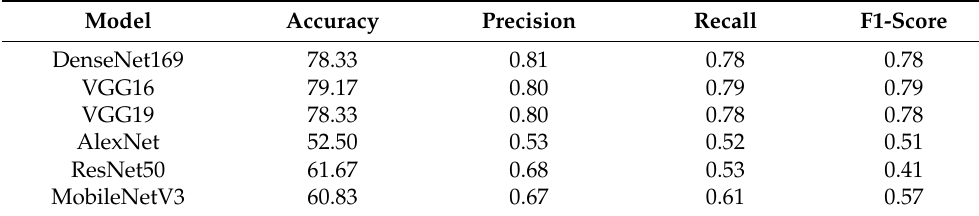
Table 7. Performance results of the deployed pretrained DL models.